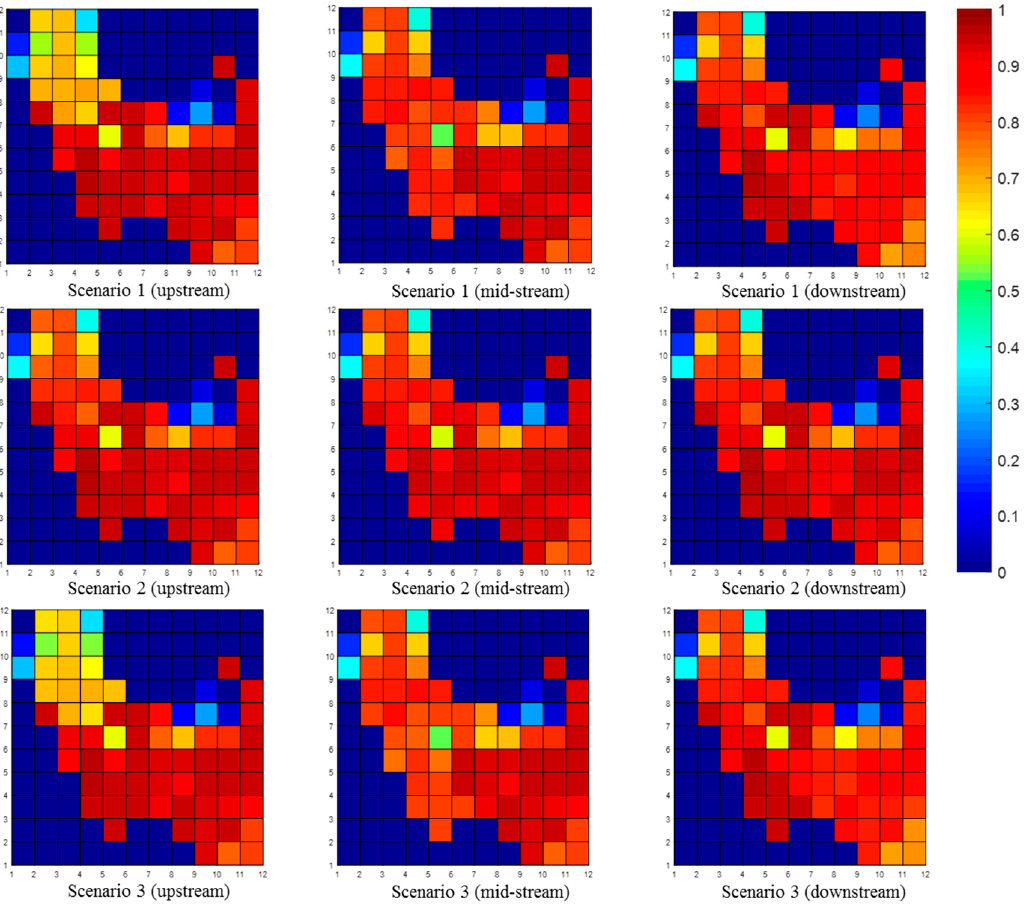
Figure 9. Application of Scenarios to WFIUH by changing the DCIA ratio on grids. The DCIA ratio is the DCIA divided by the TIA. Therefore, the closer the DCIA ratio is to 1, the more likely it is that most of the impervious area is directly connected to the drainage network. Conversely, the closer the DCIA ratio is to zero, the less direct connection to the drainage network in the impervious area. Table 5. Resulting peak flows by application of green infrastructure.